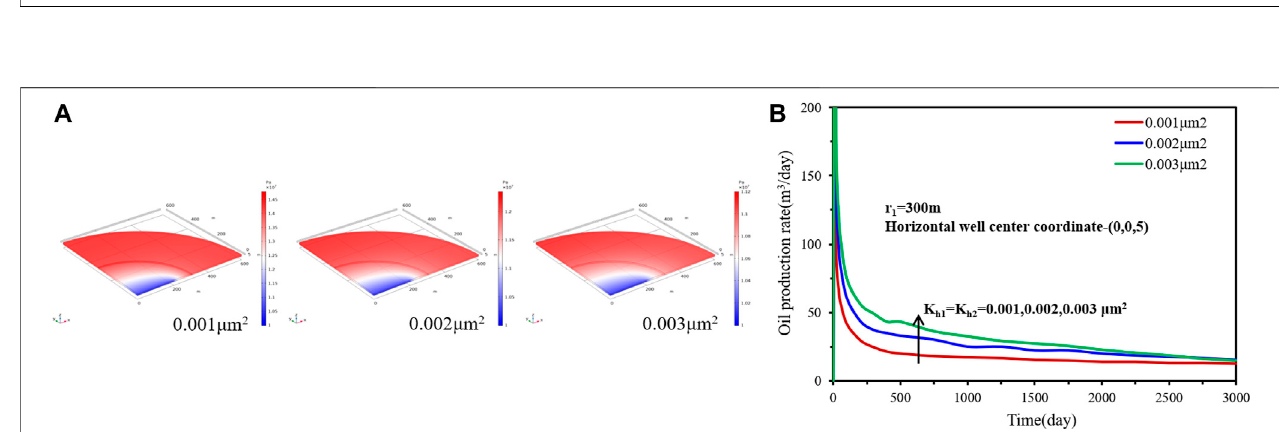
Frontiers in Energy Research |